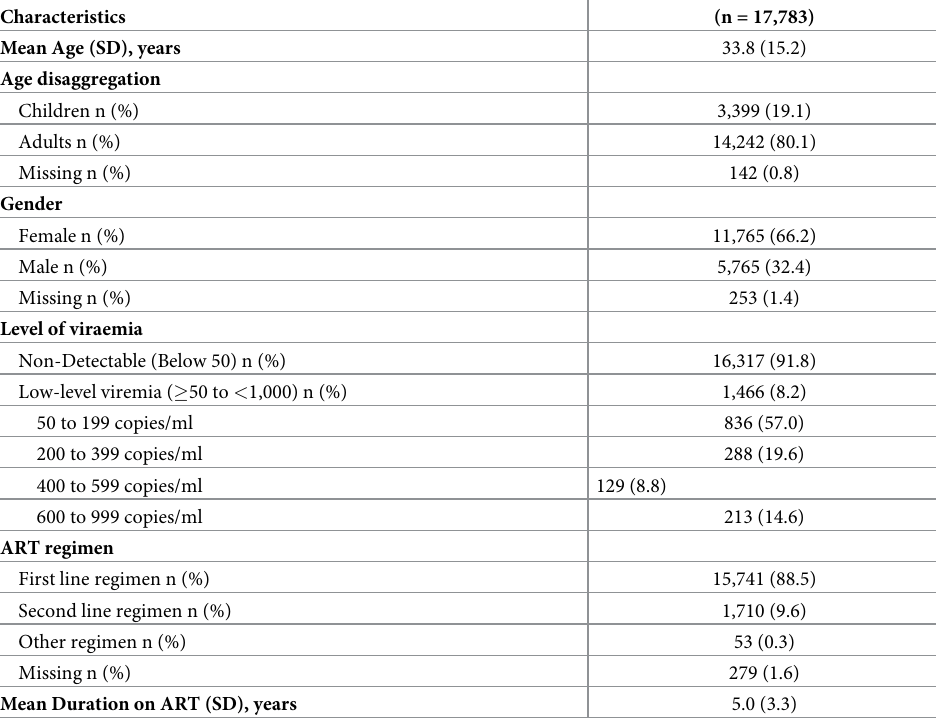
Table 2. Characteristics of the study cohort at baseline in